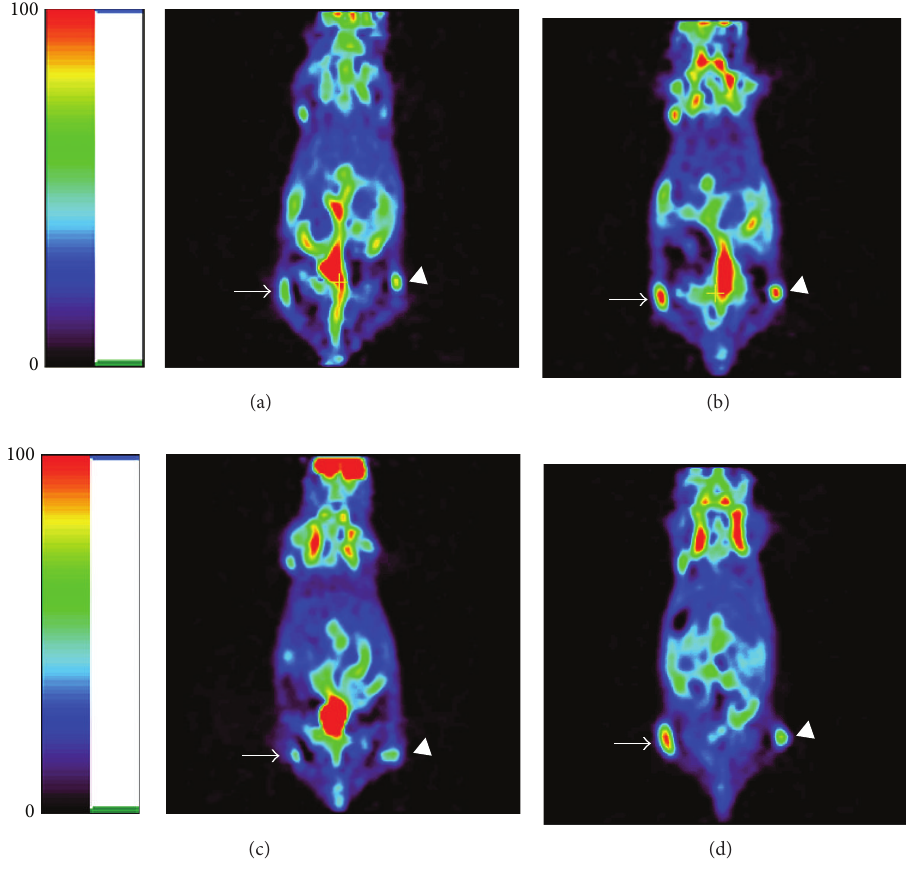
Figure 6: Representative microPET images before ganciclovir (GCV) administration ((a) and (c)) and by the end of experiment (10 days after GCV administration) ((b) and (d)). Arrow represented control C6 xenograft tumor and triangle represented C6-TK xenograft tumor in (a) and (b) and C6-sr39TK xenograft tumor in (c) and (d), respectively. SNK analysis revealed that the ratio of radioactivity (tumor/muscle) in C6-sr39TK and C6-TK group was significantly lower than the control group ( 𝑃 < 0.05 ), but not between them ( 𝑃 > 0.05 ).